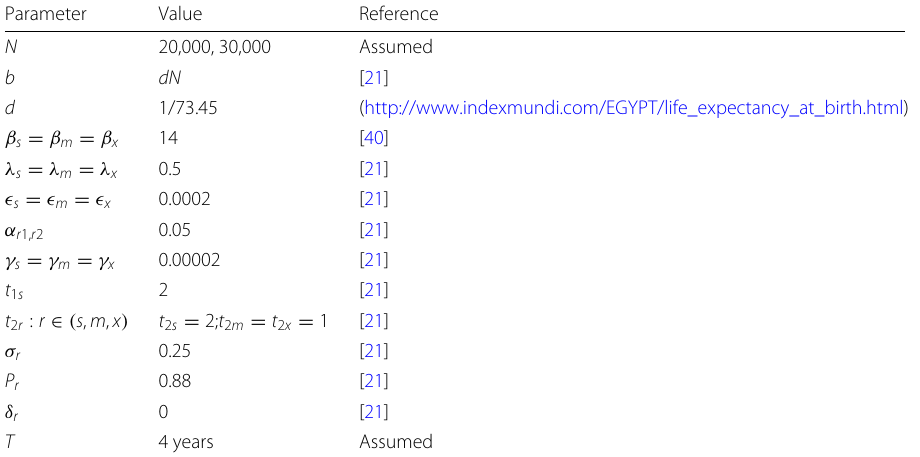
Table 2 All parameters and the references of system (1)–(8) Parameter Value Reference 20,000, 30,000